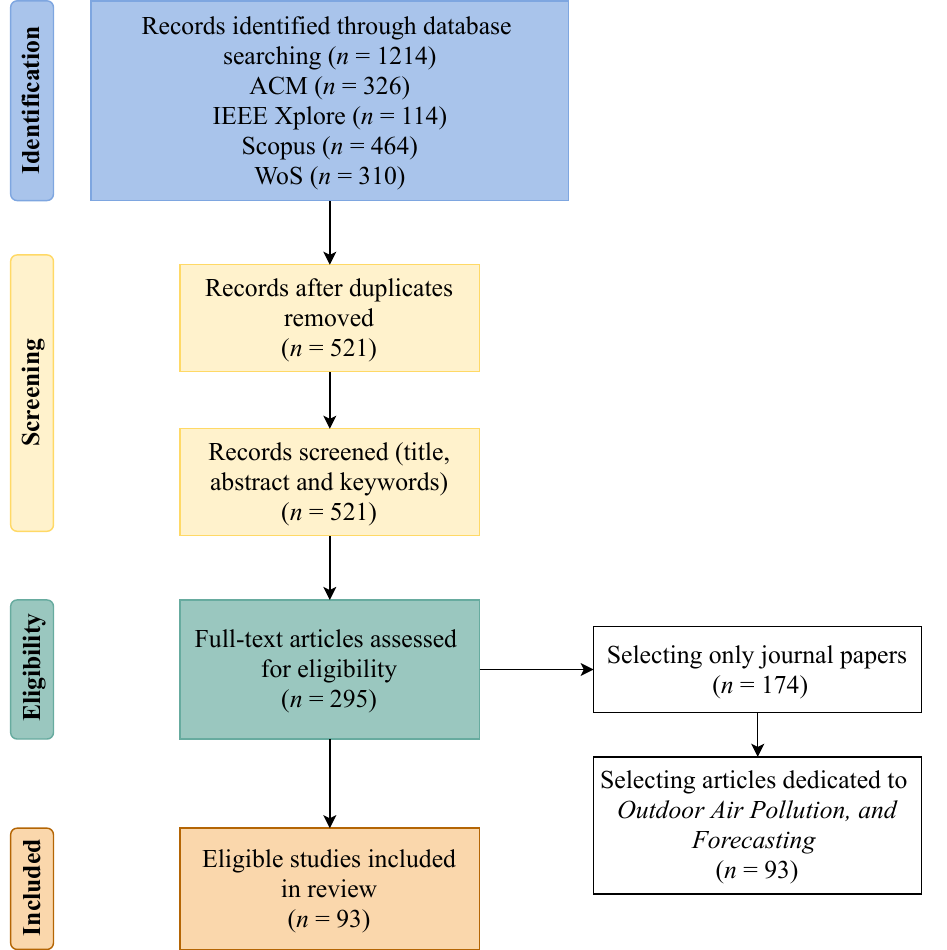
Figure 1. PRISMA flow diagram for the systematic review ( n is the number of